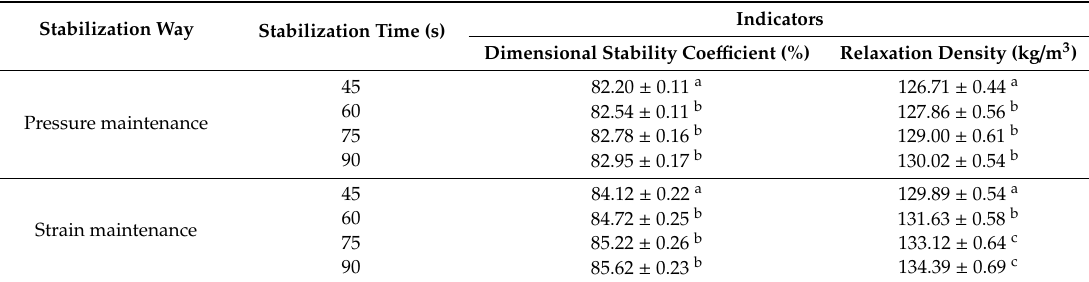
Table 3. E ff ects of stabilization time on dimensional stability coe ffi cient and relaxation density as well as significance